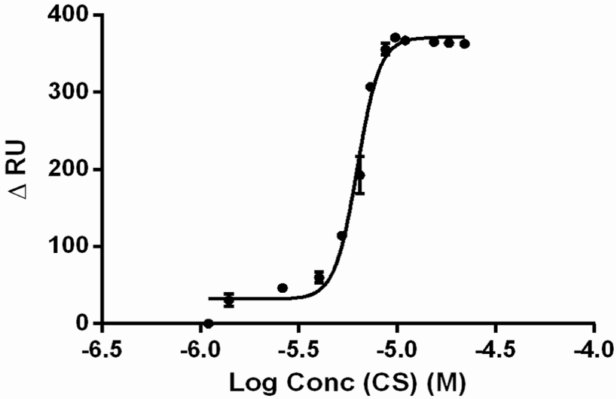
Figure 8. Saturation curve for hsa-miR-145-5p with HDP-12. Acetate buffer (35 mM, pH 5.1/10 mM NaCl) ( n = 2). Source Santos-Carballal et al. Scientific Reports 5, Article number: 13567 (2015) doi:10.1038/srep13567 [81], licensed under a Creative Commons Attribution 4.0 International